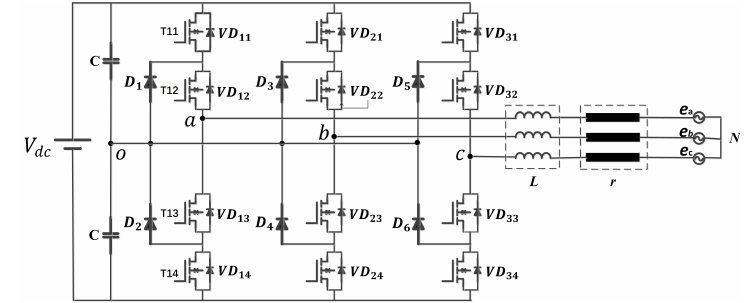
Figure 1. Three-level inverter